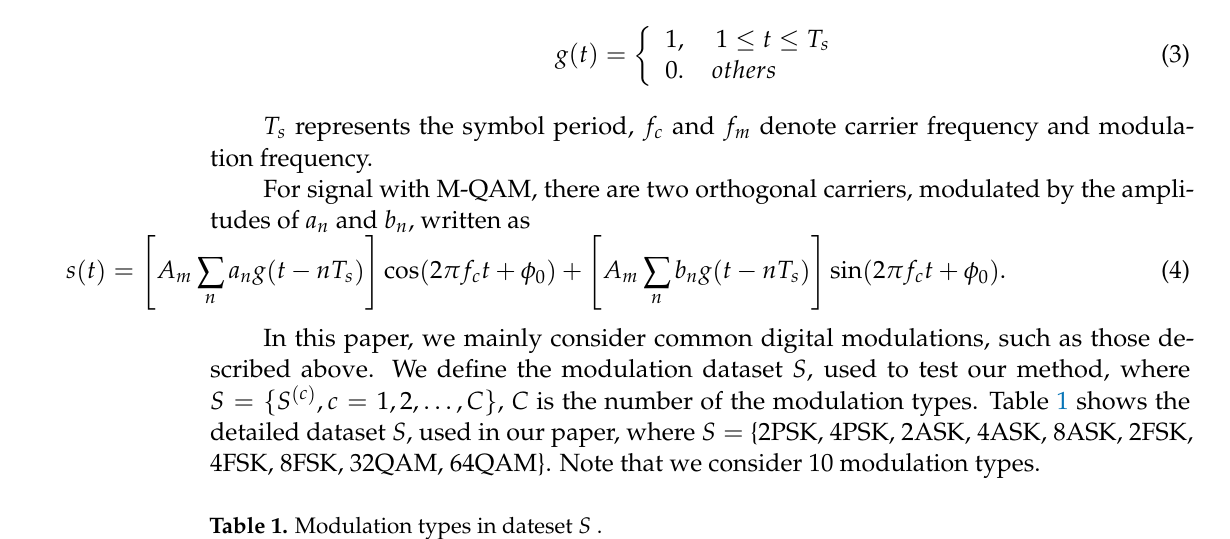
Table 1. Modulation types in dateset S